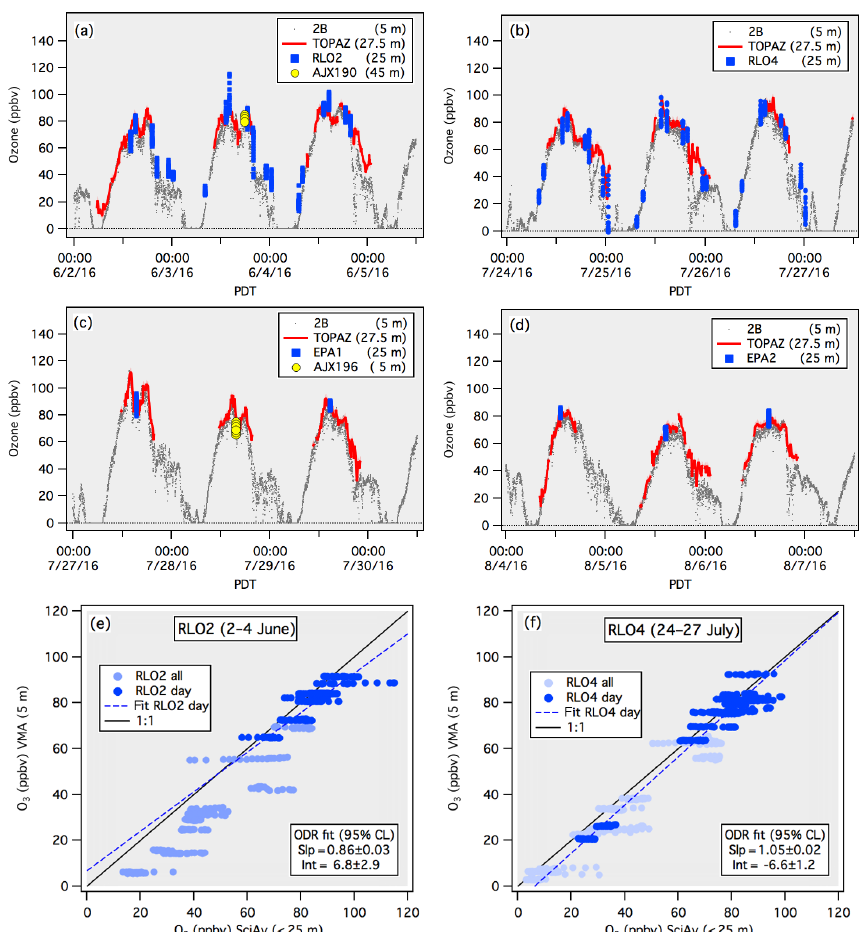
Figure 8. (a–d) Time series of the surface in situ O 3 (gray dots) and 27.5m TOPAZ O 3 (red line) measured during the RLO and EPA low approaches on (a) 2–5 June, (b) 24–27 July, (c) 27–30 July, and (d) 4–7 August 2016. The red envelope shows the TOPAZ data ± 3ppbv, the nominal accuracy of the lidar retrievals. The blue squares represent the 1s sampled (2s recorded) Scientific Aviation measurements made between the surface and 25ma.g.l. The filled yellow circles in (a) and (c) show 2s measurements from AJAX low approaches (see text). Panels (e) and (f) show scatterplots of the in situ surface measurements and the Scientific Aviation data from the RLO flights in panels (a) and (b) , respectively. The ODR fit parameters refer to the dark blue points which represent the measurements from daytime (08:30–18:30PDT)